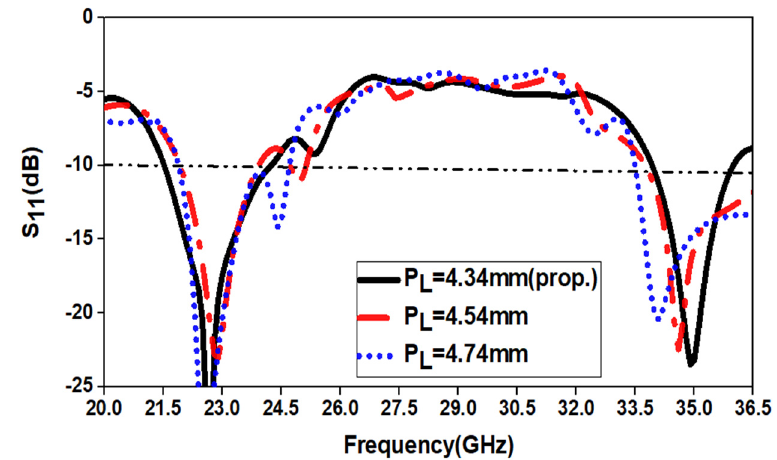
Figure 7. Analysis of variation in the length of patch element P L .